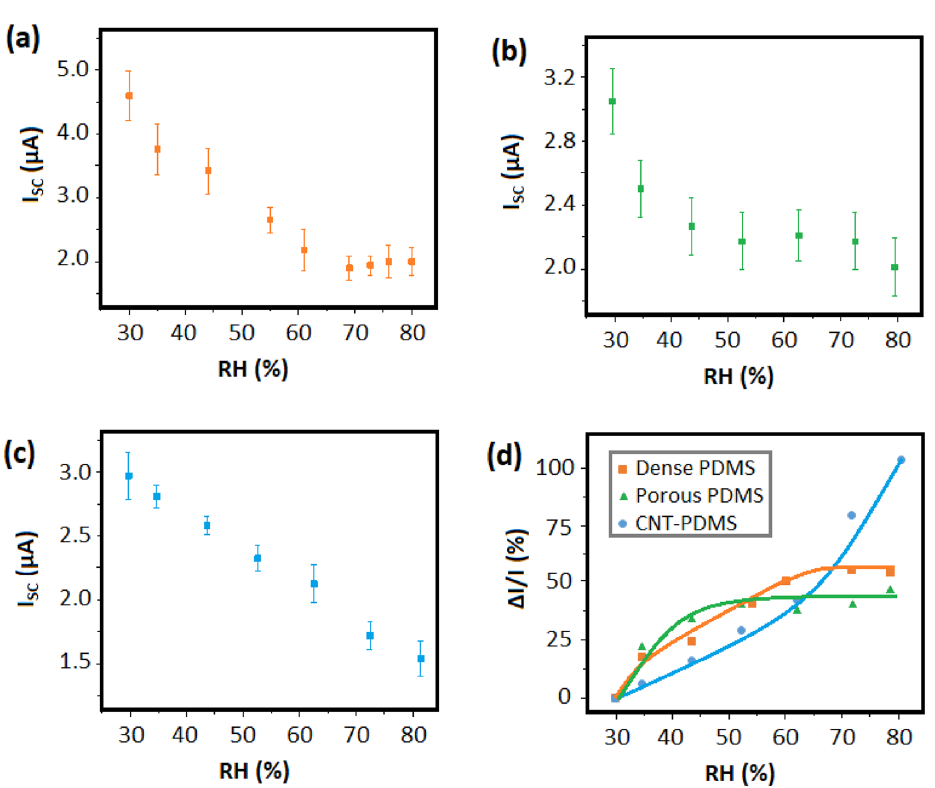
Figure 7. Sensing behavior of fabricated TENGs. Short-circuit current variations of dense PDMS ( a ), porous PDMS ( b ), and CNT-PDMS ( c ) based TENGs against RH values. Comparison of current response vs. RH for TENG-based humidity sensors ( d